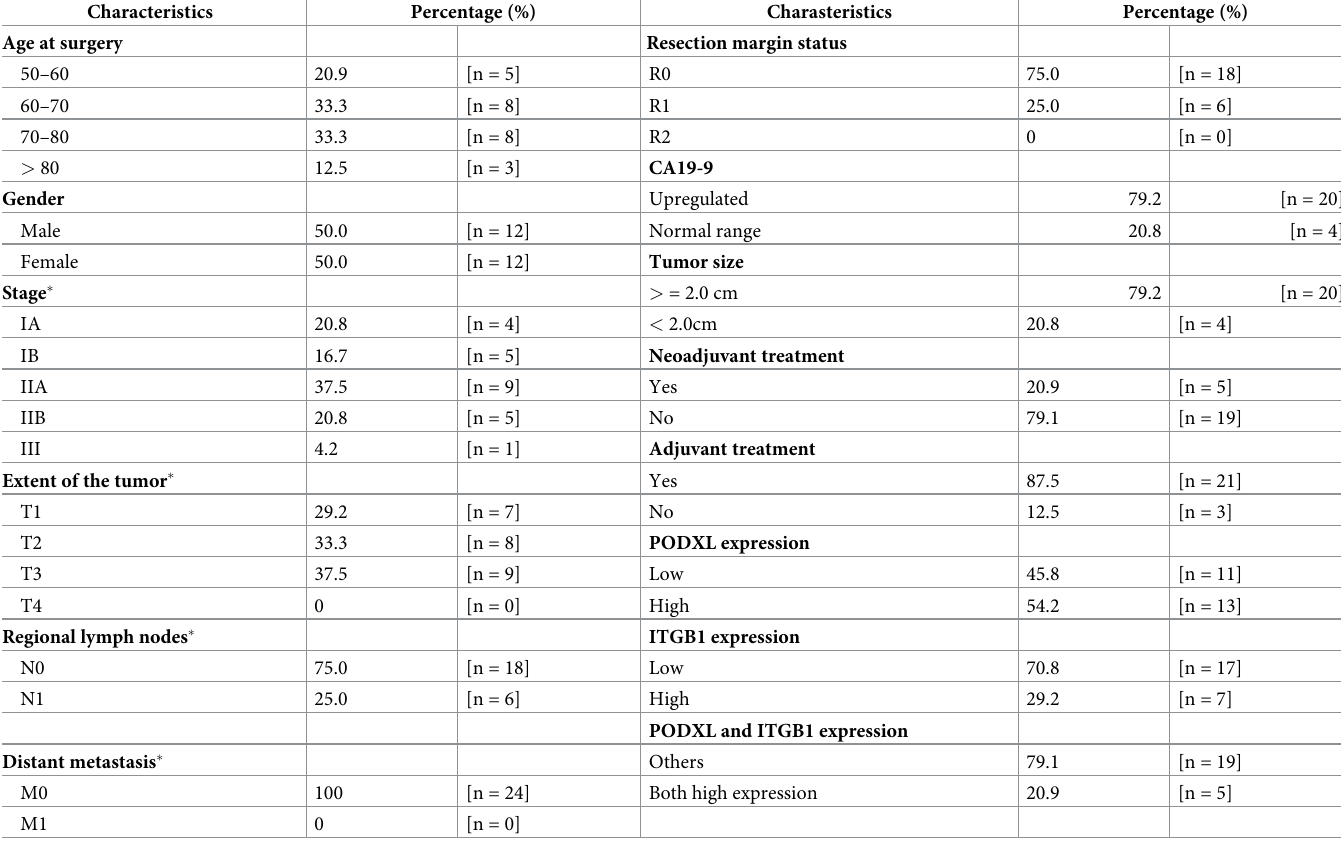
Table 1. Summary of characteristics of 24 patients with pancreatic cancer.